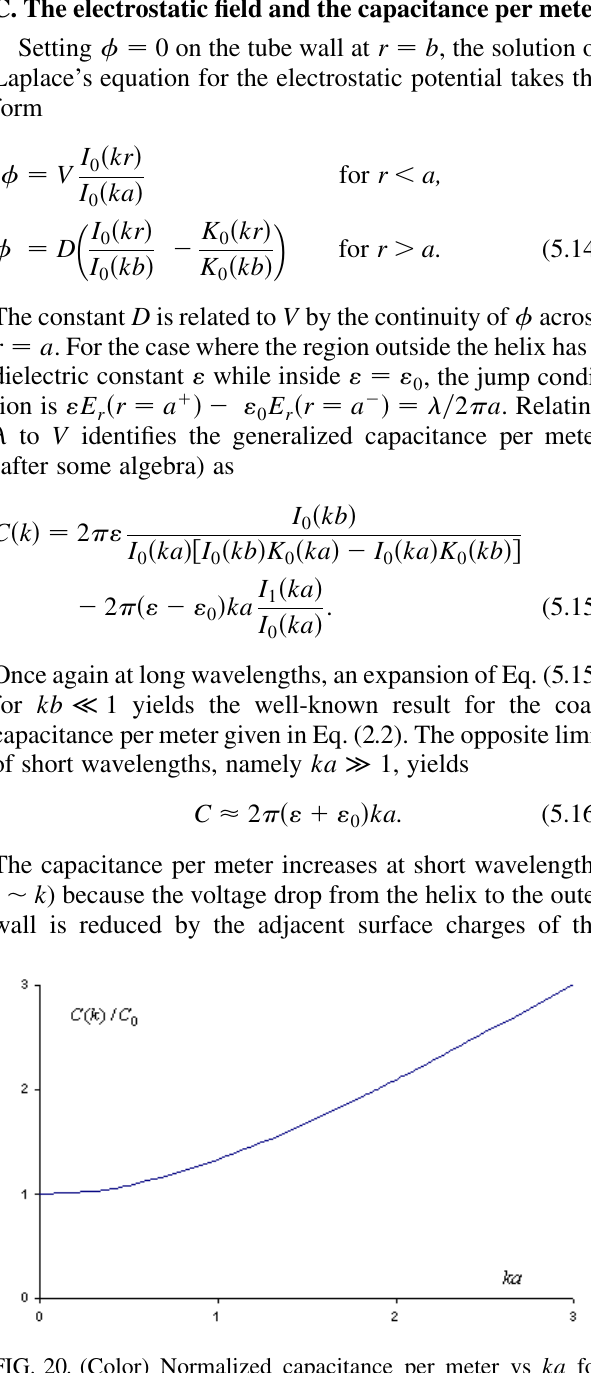
FIG. 21. (Color) Normalized phase velocity vs ka for a=b (cid:3) 0 : 6 (note the scale on the vertical axis starts at and " (cid:3) " 0